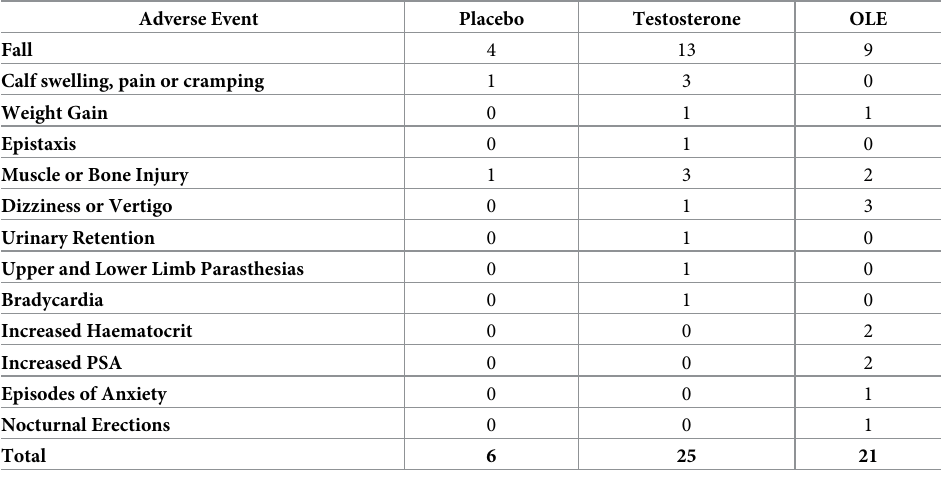
Table 5. Adverse events dependent on trial